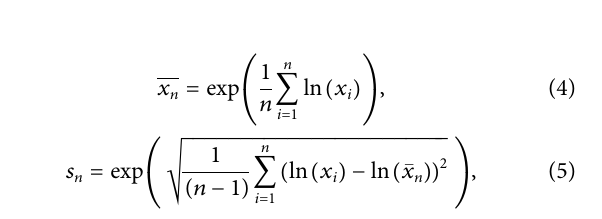
FIGURE 6 | Critical value Z (left panel) and con fi dence interval (right panel) as a function of the number of samples for the con fi dence levels 68%, 95%, 99%, and 99.9% for the standard normal distribution (dashed lines), and the standard Student distribution (solid lines).